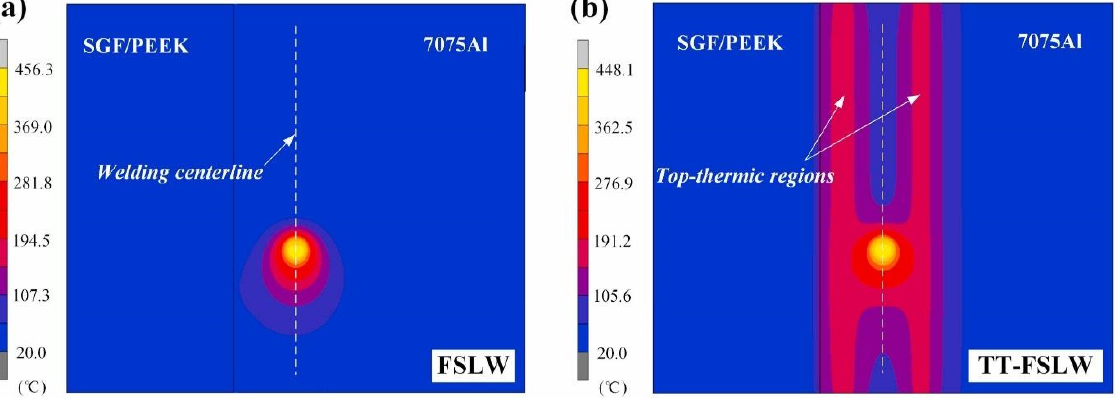
Figure 15. Temperature fields for ( a ) FSLW at 700 rpm and ( b ) TT-FSLW at 500 rpm. Reprinted with permission from Ref [87]. 2021, M. Li et al.